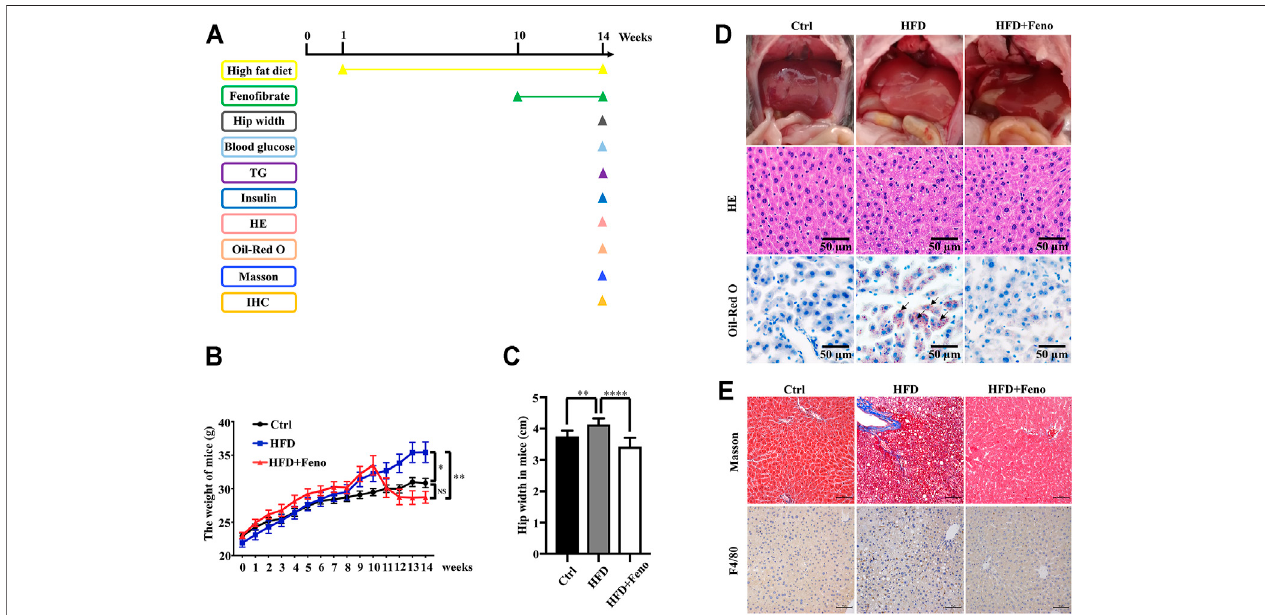
FIGURE1| Feno fi brateattenuatesbodymass,liverhistologyinHFD-fedmice. (A) Miceexperimentprocessplandiagram.Effectsoffeno fi brateonbodyweight (B) and hip-width (C) after 14 weeks. These results are means ± SD ( n (cid:1) 6 − 10 mice/group). * p < 0.05, ** p < 0.01, **** p < 0.0001, HFD group versus control group, or feno fi brate + HFD-fed group versus HFD group. (D) Liver gross morphology, hepatic macrosteatosis, and fat deposition of mice in each group (original magni fi cation × 200; scale bar, 50 μ m). (E) Masson staining and F4/80 staining of liver tissue in each group (magni fi cation × 200; scale bar, 50 μ m).